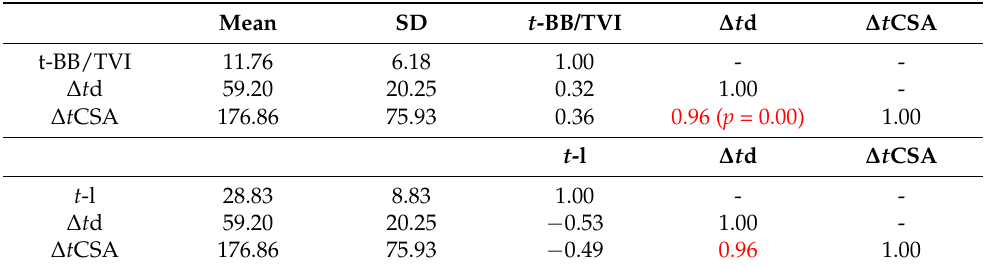
Table 4. Results of correlation analysis for the tibia for t(I-S) = from 31 to 60 days. Correlation coefficients are statistically significant at p < 0.05 (in